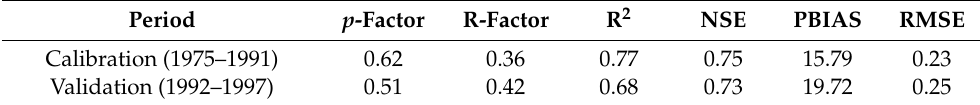
Figure 5. Observed and simulated monthly runoff for the calibration (1975–1991), the validation (1992–1997) and the impact period (1998–2019) of the Xilin River Basin. Table 5. Performance of flow simulation for the Xilin River Basin using the SWAT